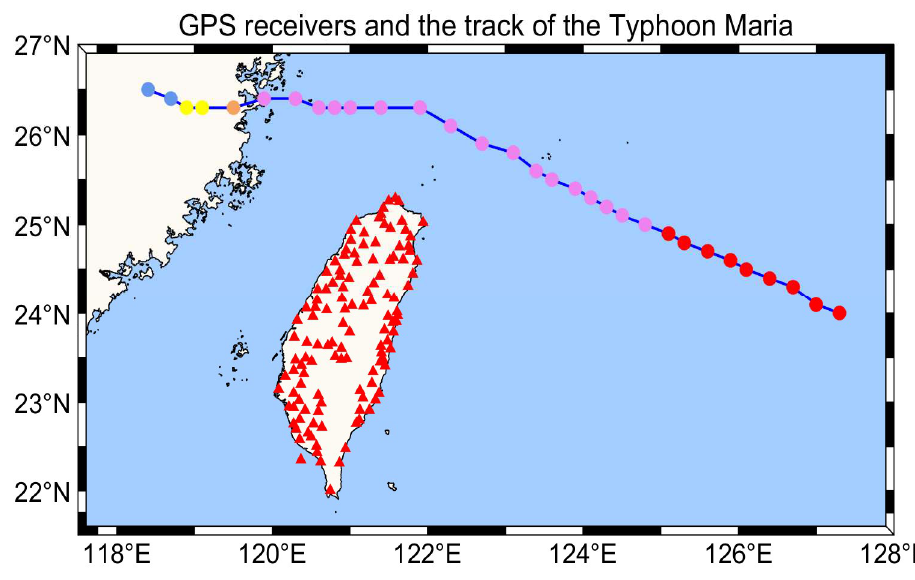
Figure 1. GPS receivers(triangles) and the track of Typhoon Maria(colorful Figure 1 . GPS receivers(triangles) and the track of Typhoon Maria(colorful circles).